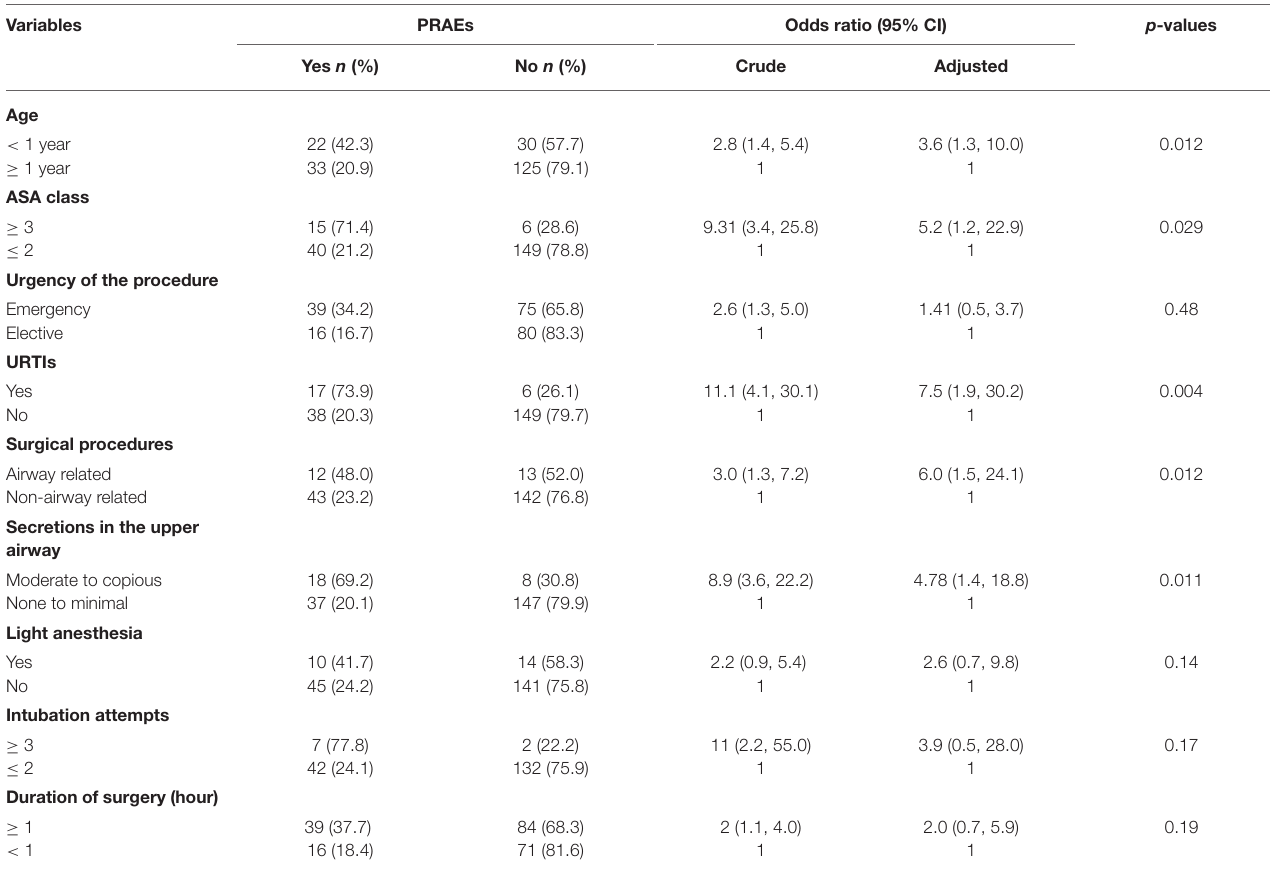
TABLE 5 | Bivariate and multivariate binary logistic regression analysis: factors associated with PRAEs in pediatric surgical patients underwent surgery under general anesthesia in UoGCSH and TGSH, Northwest Ethiopia; March 1–May 30, 2020 ( N = 210).